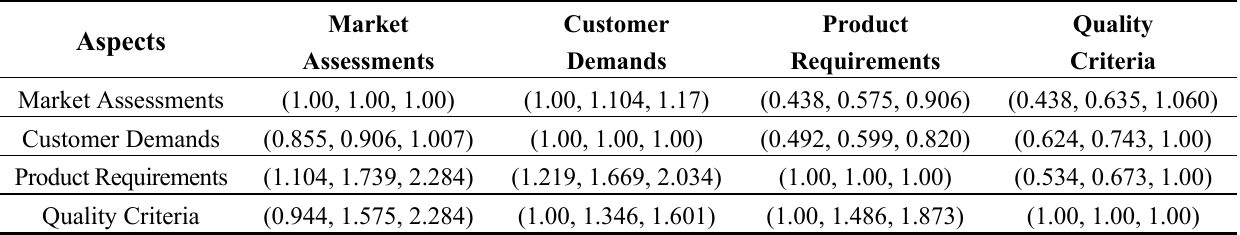
Table 8. Fuzzy Pair-wise Comparison